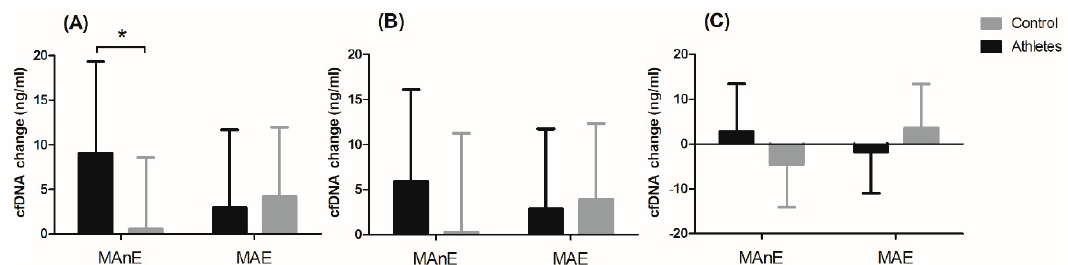
Figure 2. Changes in cell-free DNA (cfDNA) from baseline to u to 5 min after ( A ) and 30 min ( B ) and 60 min ( C ) after maximal anaerobic (MAnE) and aerobic effort (MAE) in the athletes and controls. * significant difference vs. control group at p < 0.01.